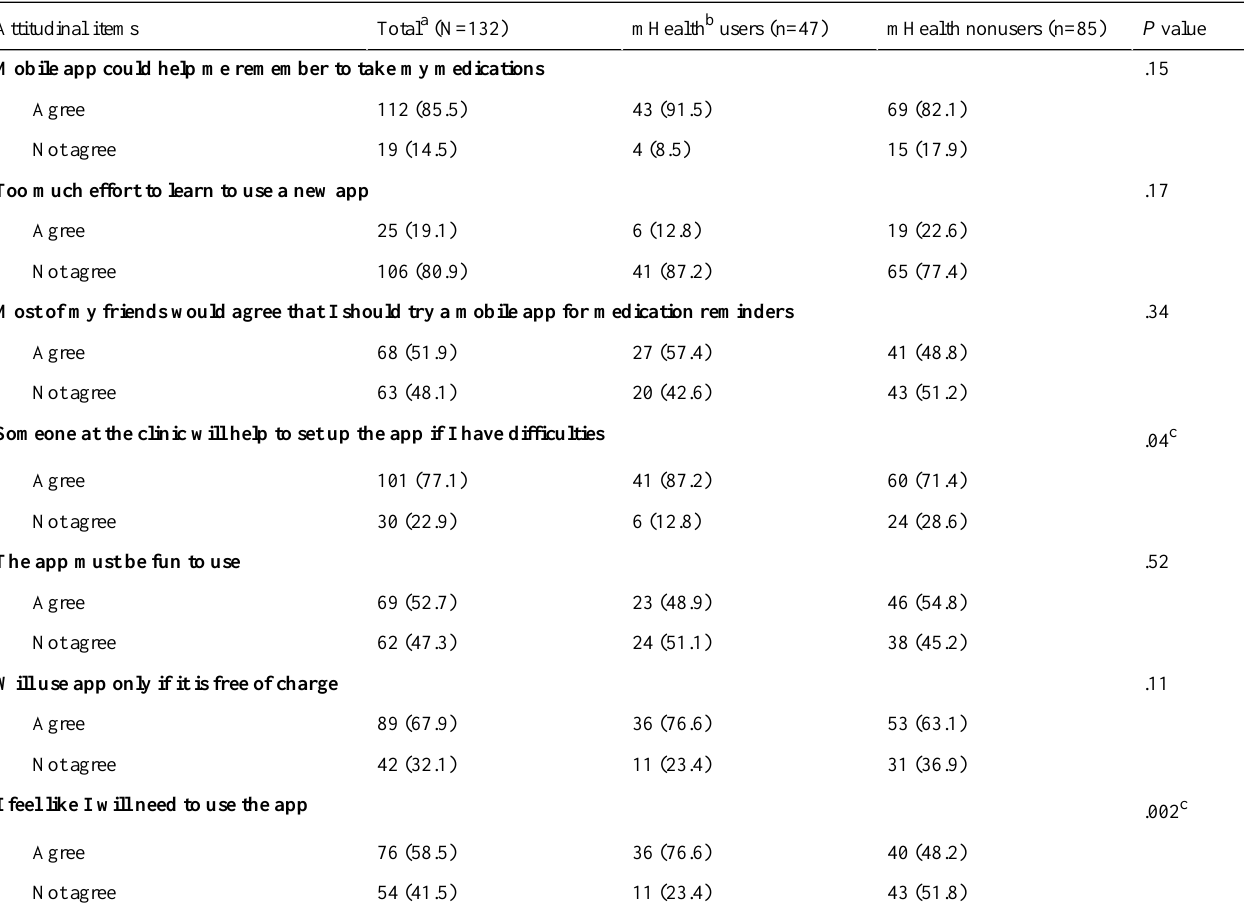
Table 2. Participants’ attitudes at baseline, regarding utility of a mobile health app for people living with HIV/AIDS (PLWH) in the Florida mHealth Adherence Project for PLWH Study, 2015-2016.